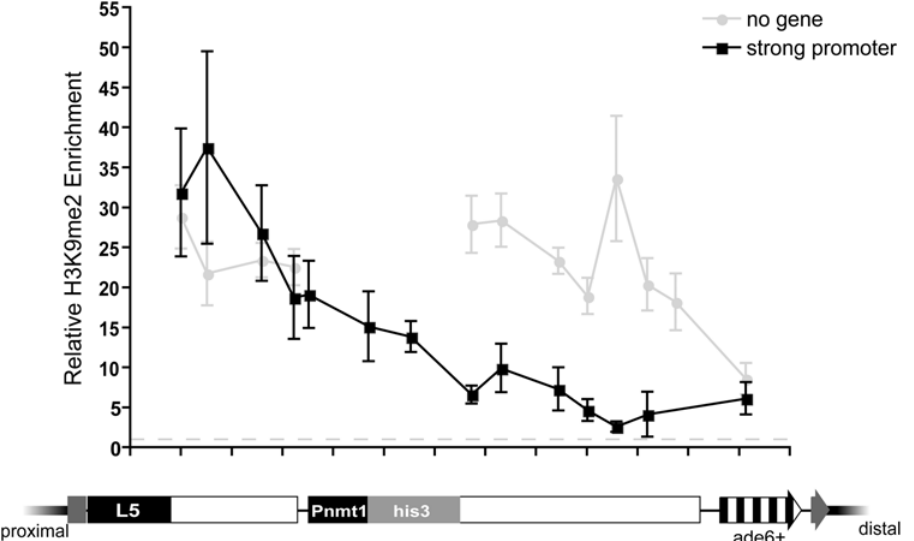
Figure 3. The presence of Pnmt1-his3 attenuates heterochromatin spreading. H3K9me2 enrichment in is shown for strains in which Pnmt1- his3 + has been inserted within lambda (black) or containing uninterrupted spacer DNA (grey).